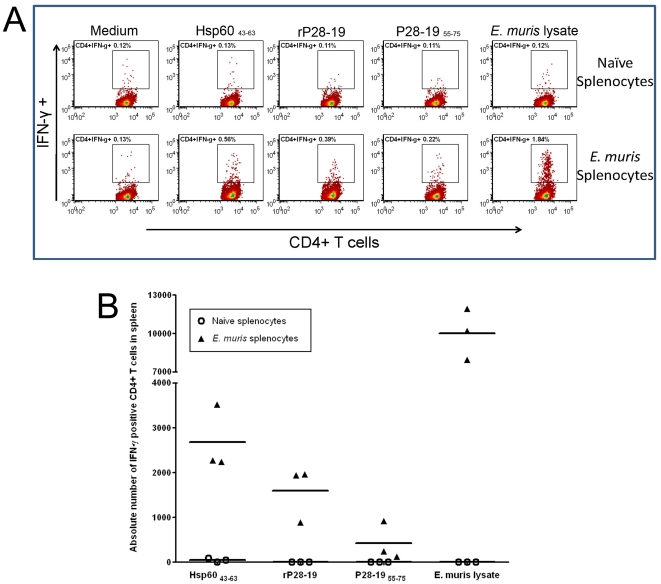

Ehrlichia Hsp60 43–63 and P28-19 55–75 -specific memory CD4+ T cells develop during E. muris infection.We determined by flow cytometry the frequencies and absolute numbers of Ehrlichia Hsp60 43-63- and P28-19–specific IFN-γ-producing CD4+ T cells in the spleen of mice infected with E. muris. (A) Mice infected with E. muris had higher frequency of Ehrlichia Hsp60 43–63- and P28-19 55–75 -specific IFN-γ-producing CD4+ T cells in the spleen on day 45 after infection compared to naïve uninfected mice. Representative dot plots were gated on live cells followed by CD3+ T cells (B) Absolute numbers of E. muris-specific IFN-γ-producing CD4+ T cells in the spleen of the same mice detected following in vitro stimulation with the Ehrlichia Hsp60 43–63, P28-19 55–75 peptides; rP28-19 and E. muris whole cell lysate are shown for comparison. Horizontal bars represent the mean; data are representative of two independent experiments (n  = 3 animals per group).